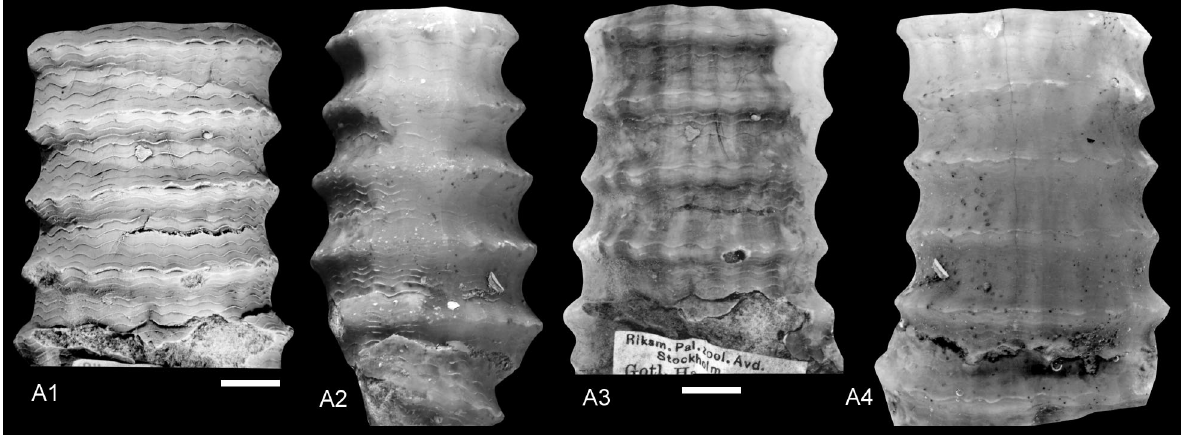
Fig. 1. A1(cid:150)A4 , Dawsonoceras annulatum (Sowerby, 1816), RM Mo 47793, Hangvar kanal, H(cid:246)gklint Beds, Wenlock, lower Sheinwoodian. Ventral (A1, A3), lateral (A2) and dorsal (A4) view. Scale bars equal 5 mm. Specimens figured as Fig. A2(cid:150)A4 were immersed in alcohol before